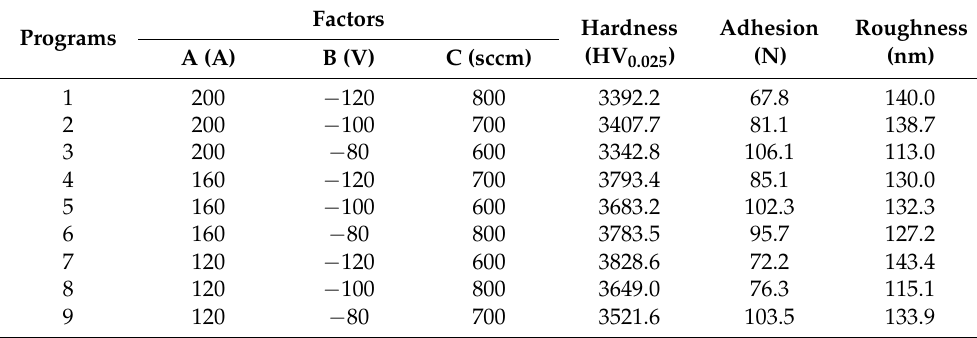
Table 3. Results of the orthogonal